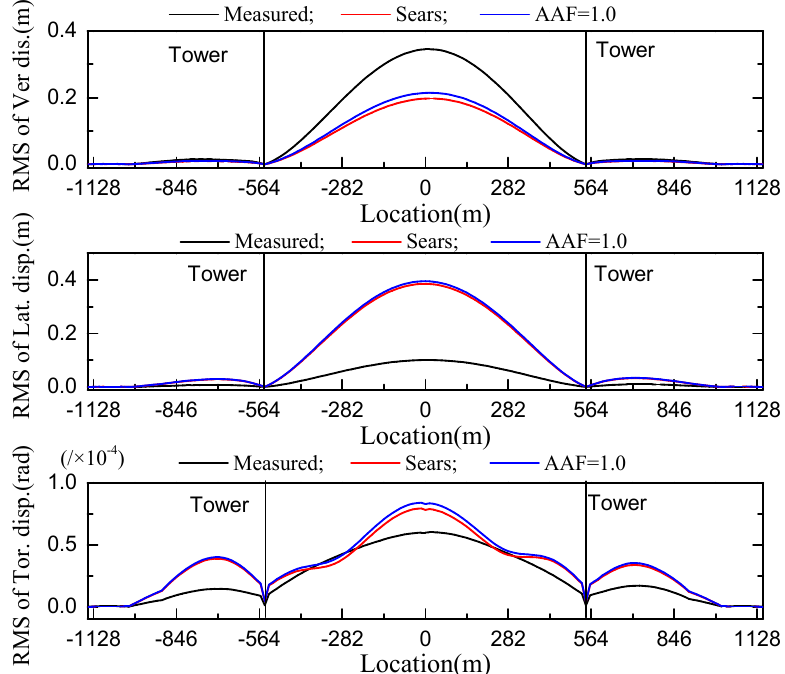
Figure 18. RMS of the truss girder displacements at the service stage under different AAFs.